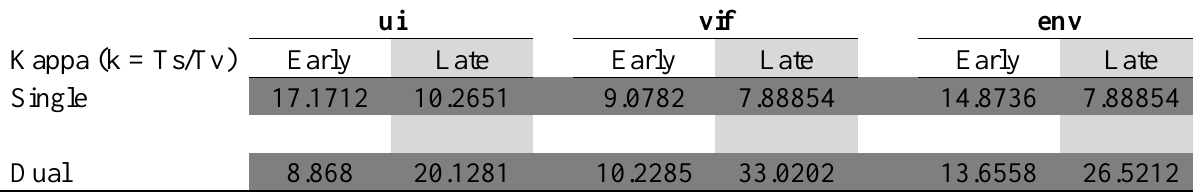
Horizontal dark grey shading shows the trend from early to late for each gene of the respective infection group. The vertical light grey shading shows the trend in late